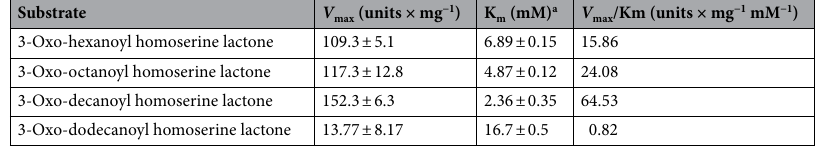
Table 1. Kinetic data for the conversion of 3-oxo-acyl homoserine lactones by GqqA. a For the Michaelis– Menten fits see Figure